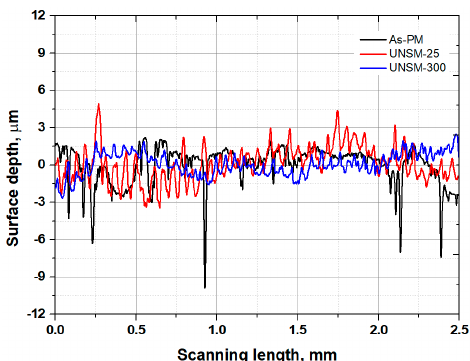
Figure 5. Comparison in surface roughness results of the as-PM, UNSM-25 and UNSM-300 samples.